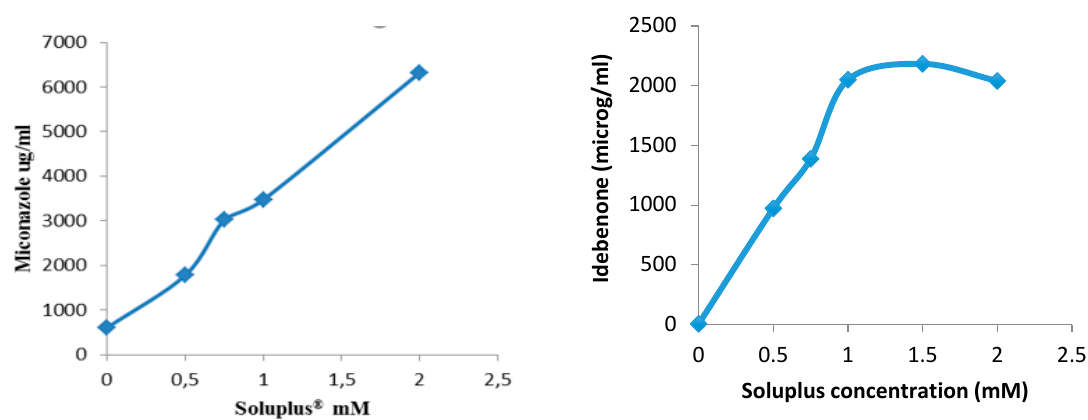
Figure 21. Solubility profiles of miconazole (left) and idebenone (right) as a function of Soluplus ® concentration.